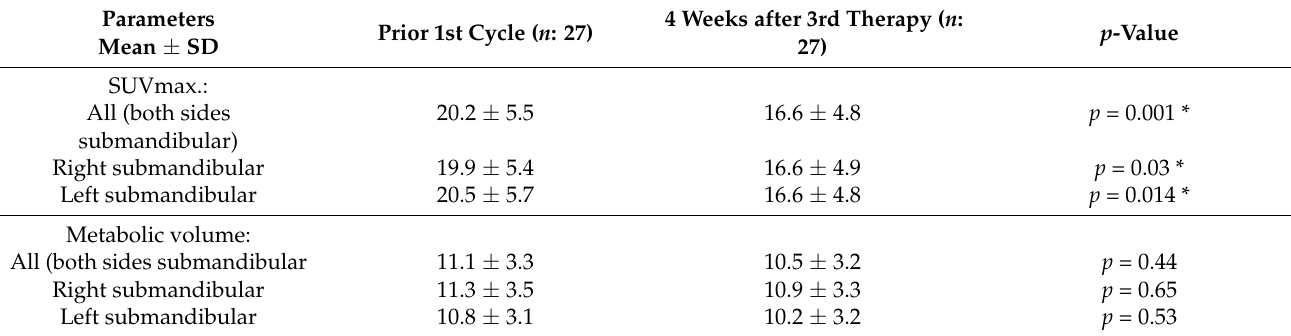
Table 4. [ 68 Ga]Ga-PSMA PET parameters of salivary glands directly before and 4 weeks after receiving 3 cycles of PSMA-